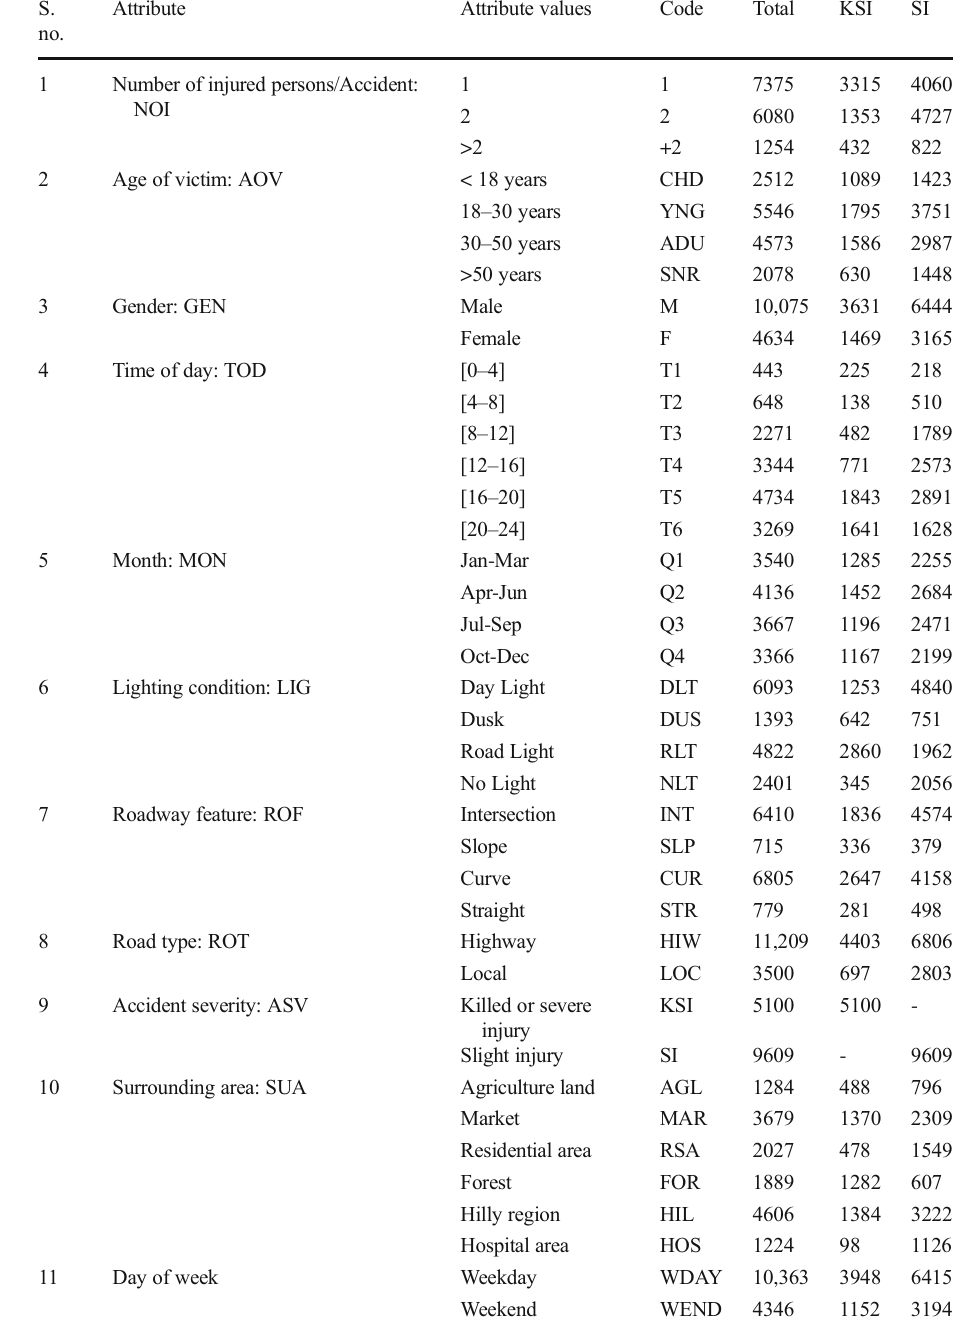
Table 1 PTW road accident data